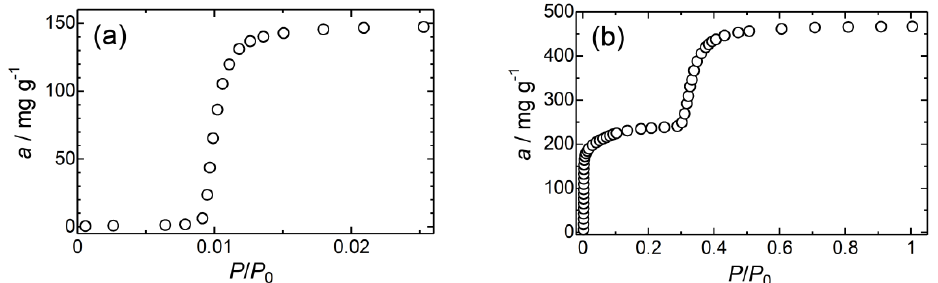
Figure 1. CO 2 sorption isotherms for ELM-11 at ( a ) 273 K and ( b ) 195 K.